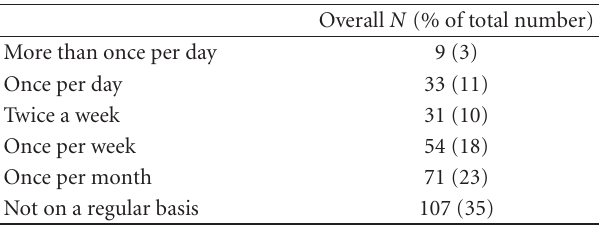
Table 2: Self-blood-pressure monitoring frequency reported by self-monitoring respondents ( n =